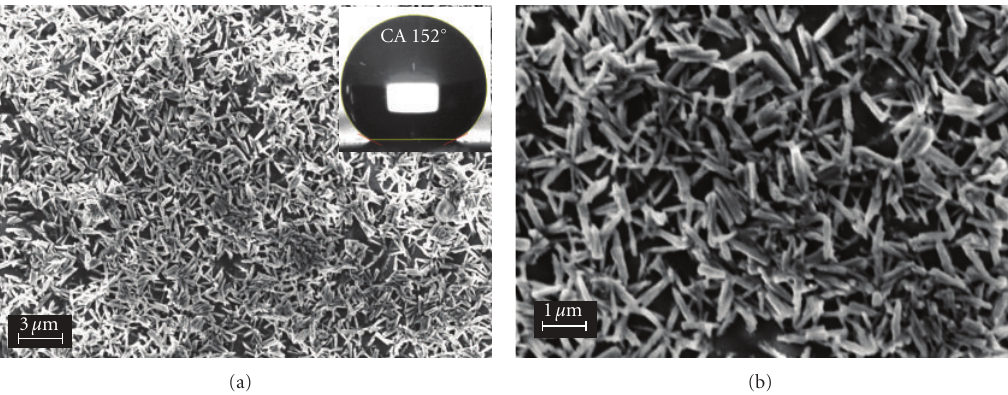
Figure 3: Surface morphology of ZnO coating treated with fluoroalkylsilane at 2500X (a) and 5000X (b). Inset shows the image of water drop on the film surface.